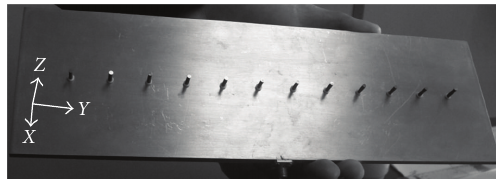
Figure 1: The array antenna is composed of 12 monopoles.